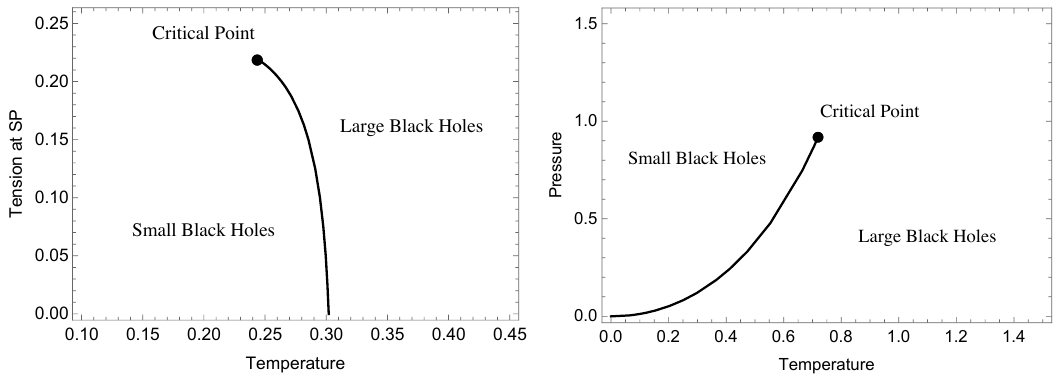
Figure 5 . A plot of the free energy as a function of temperature for varying tension with Q = 0 : 05 ‘ on the left, and varying charge with 4 (cid:22) (cid:0) = 0 : 3 on the right.